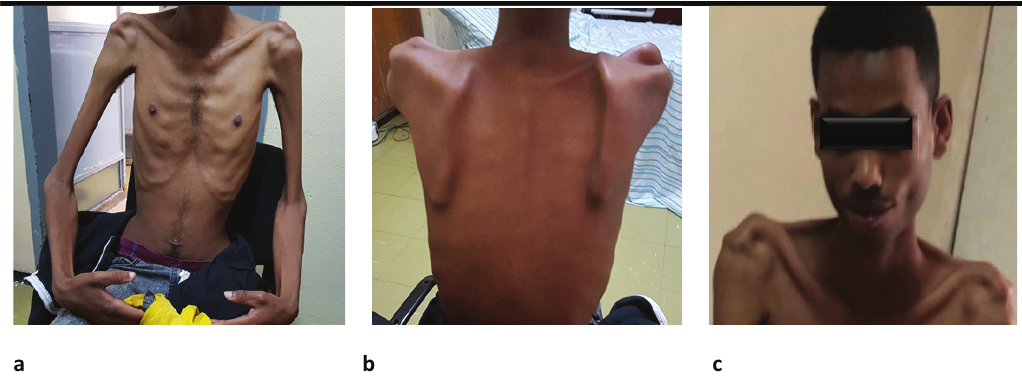
Figure 1: (a) Image showing significant muscular atrophy of intercostal, pectoralis, arm, and shoulder girdle muscles. (b) Image showing bilateral scapular winging while the patient extends his upper limbs. (c) Image showing slim elongated face with modest facial